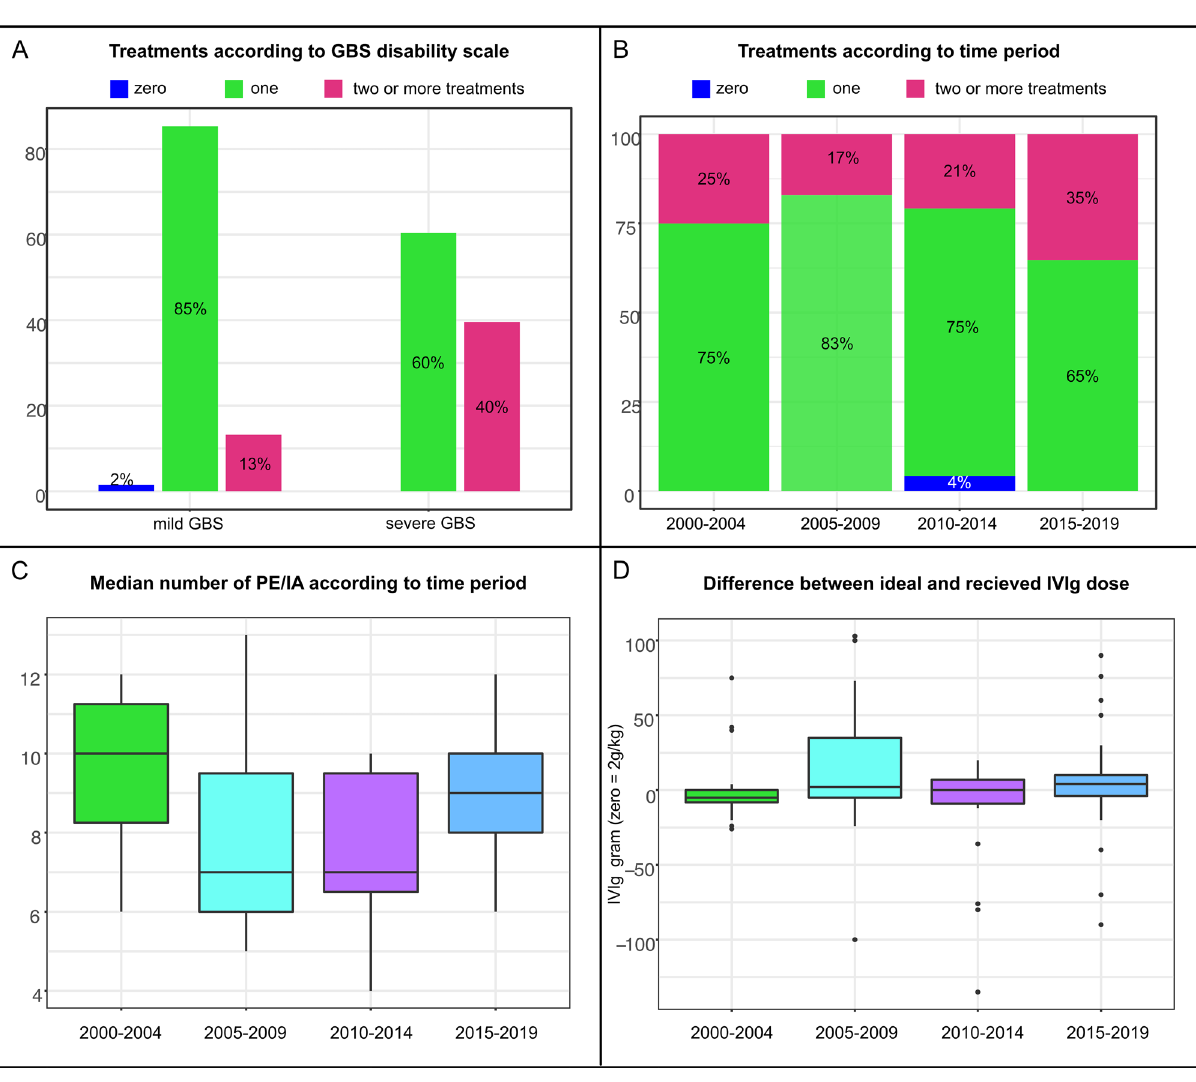
non-ambulatory). ( B ) Number of treatments for each time period of diagnosis grouped into 5-years intervals between 2000 and 2019. ( C ) Boxplots of the median number of plasma exchanges (PE) or immunoadsorption (IA; one patient) for each time period of diagnosis grouped into 5-years intervals between 2000 and 2019. The lower and upper hinges correspond to the first and third quartiles and the lower and upper whisker extend from the hinge to the smallest and largest value no further than 1.5 times the interquartile range from the hinge. Outliers are plotted individually as black points. ( D ) Boxplots of the median difference between the ideal IVIg dose (defined as 2 g per kilogram bodyweight) and the actual received dose. Boxplots are shown for all IVIg treatments in each time period of diagnosis grouped into 5-years intervals between 2000 and 2019. Definition of hinges and whisker is the same as in C and outliers are plotted individually as black